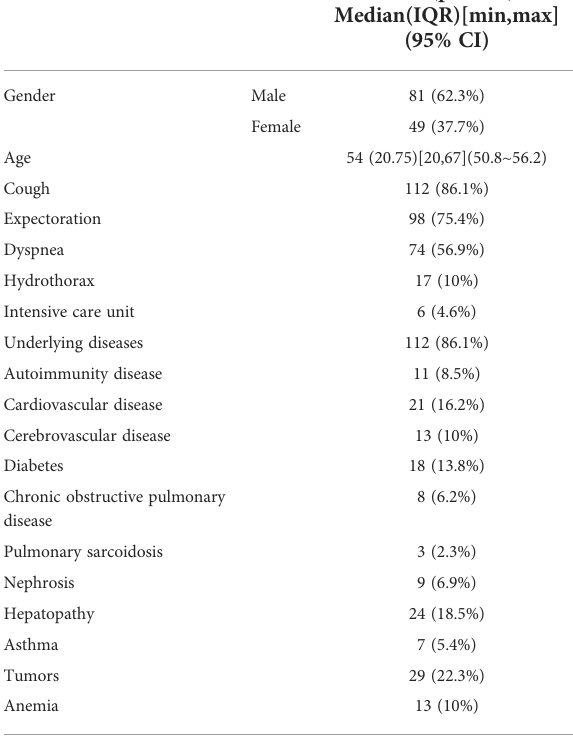
TABLE 1 Clinical characteristic of enrolled patients. Clinical